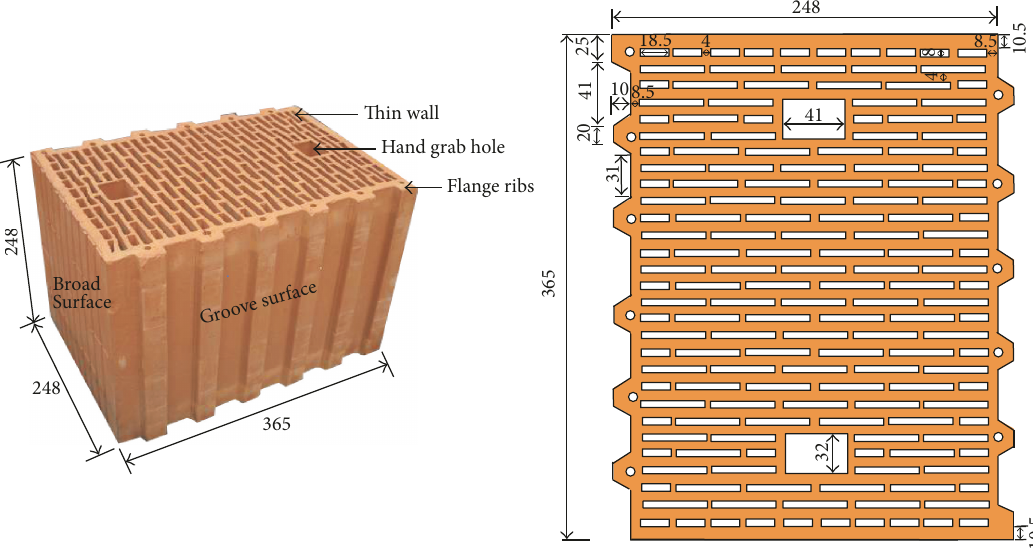
Figure 1: Detailed dimensions of a hollow shale block (in mm).